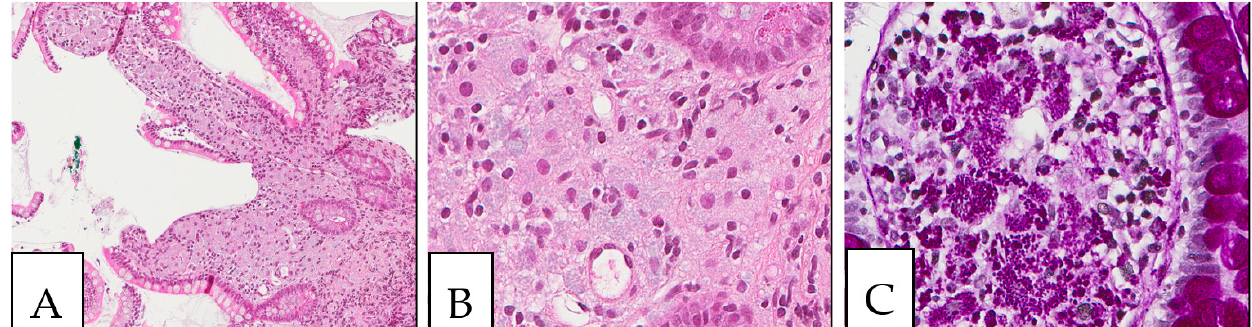
Figure 9. Whipple disease. ( A,B ) Histiocytic accumulation with a foamy to eosinophilic cytoplasm in the duodenal lamina propria. ( C ) . PAS-positive histiocytes in the duodenal lamina propria. The biopsy was obtained from a 43-year-old female patient investigated by endoscopy for anemia; PCR was positive for Tropheryma whipplei .